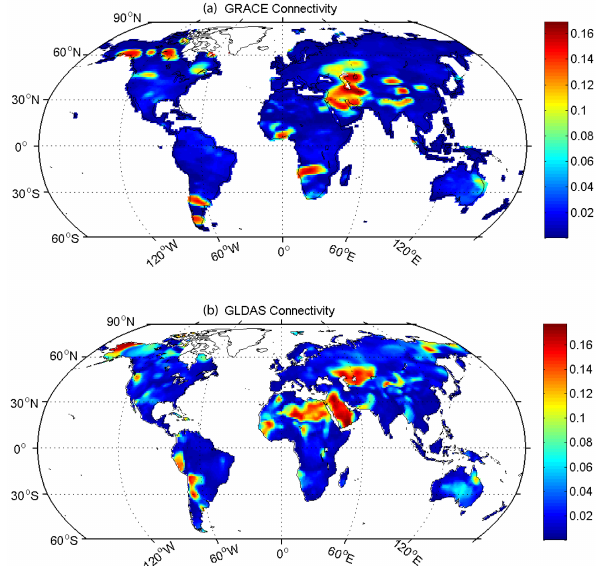
Figure 5. Area-weighted connectivity map obtained using (a) GRACE and (b) GLDAS data (zero-lag correlation).